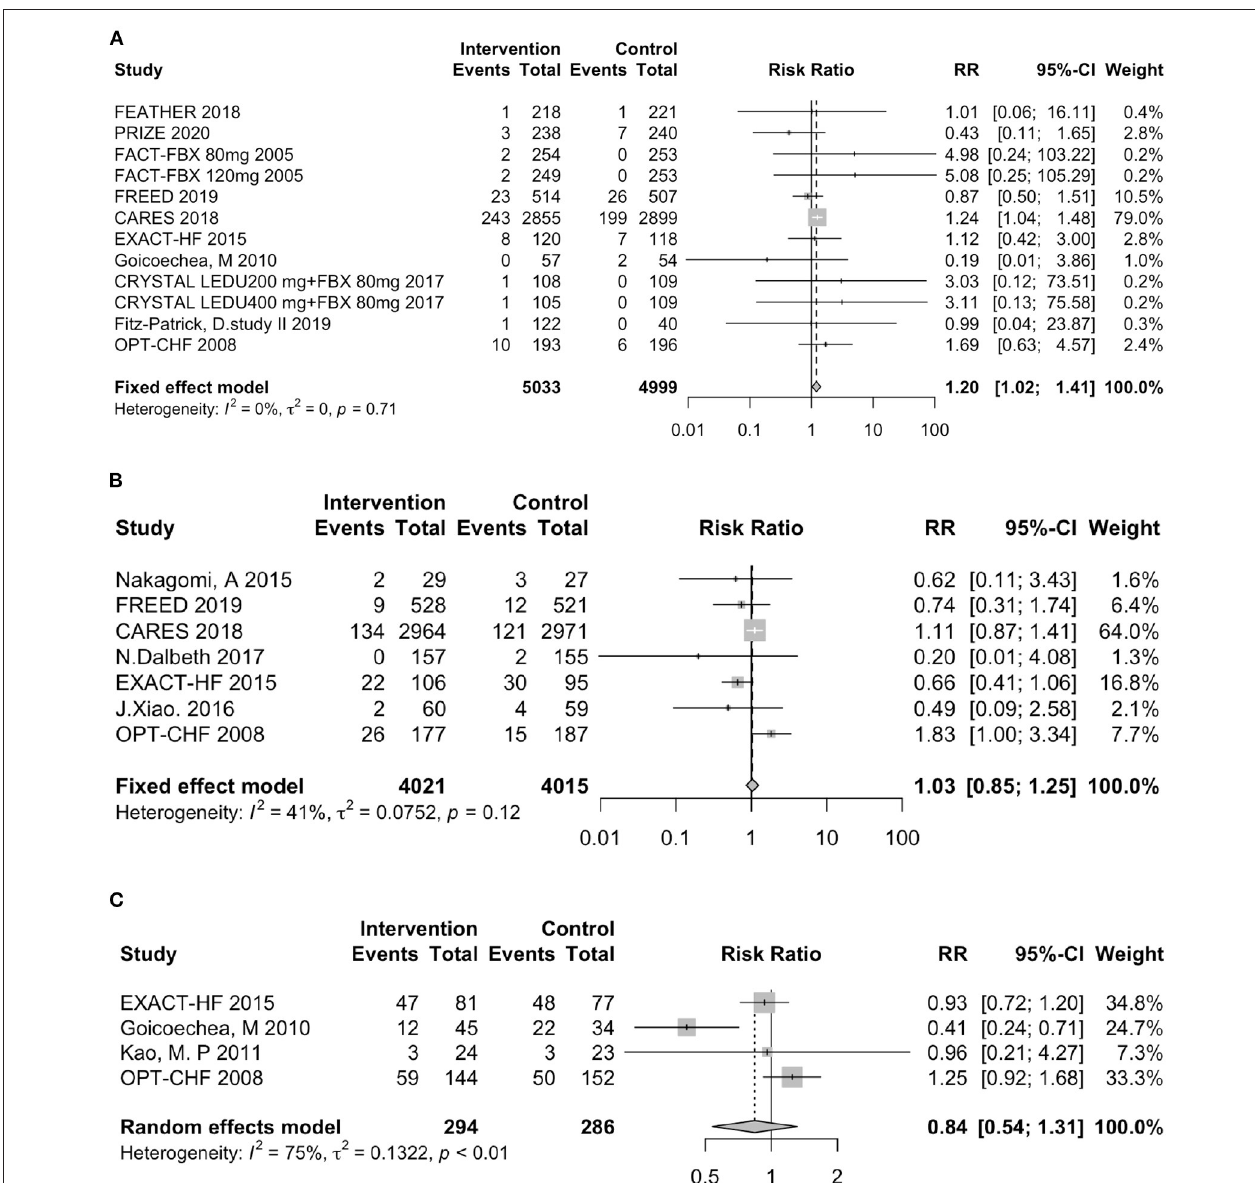
FIGURE 4 | Assessment of clinical outcomes. (A) Forest plot of all-cause mortality. (B) Forest plot of heart failure-related hospitalization. (C) Forest plot of all-cause hospitalization. RR indicates risk ratio; CI indicates confidence